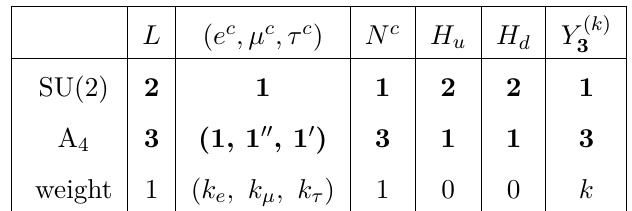
triplet L , and 4 singlets 1 , 1 00 and 1 0 , respectively. 4